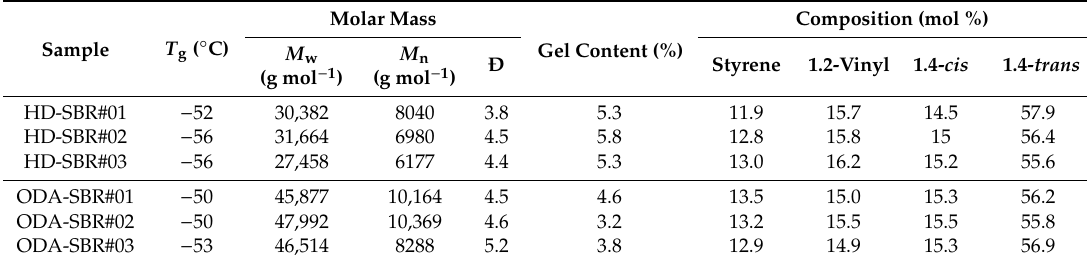
Table6. PropertiesofSBRlatexessynthesizedusingHDandoctadecylacrylate(ODA)asthehydrophobe.